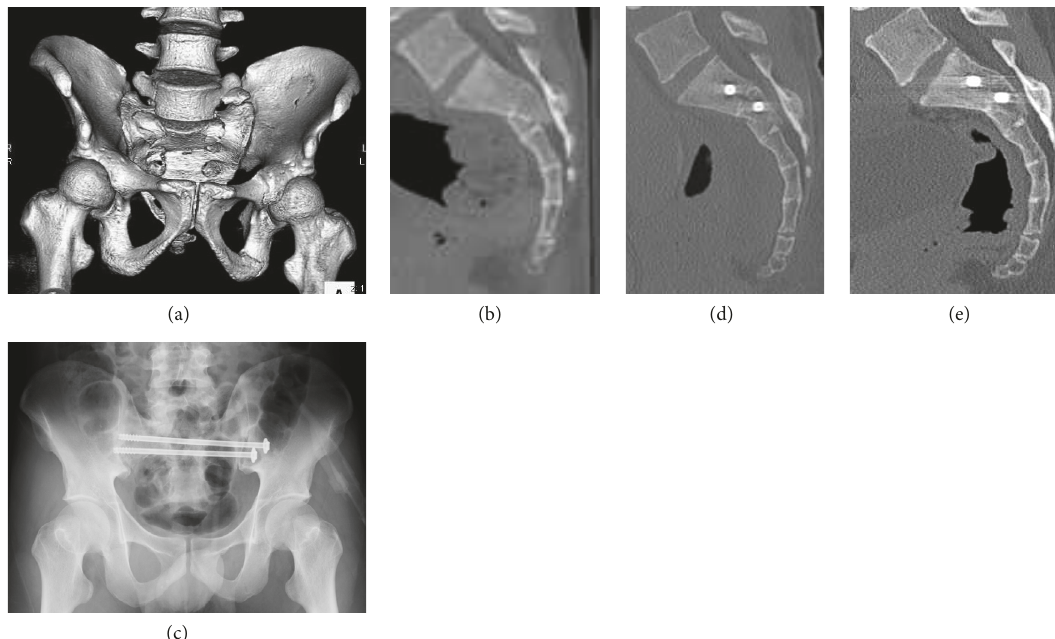
Figure 3: Case 1. A 25-year-old man who was injured from a fall from a height underwent S1 and S2 TSTI partial threaded screw fixation for a Roy-Camille type 2 U-shaped transverse sacral fracture. (a) Preoperative 3-dimensional CT reconstruction of the pelvis is shown. (b) Preoperative CT scan of the sacrum in the sagittal plane is shown (preoperative sacral kyphotic angle: 33 ∘ ; fracture translation: 10 mm). (c) Postoperative anteroposterior radiograph of the pelvis is shown. (d) Postoperative CT scan of the sacrum in the sagittal plane is shown (postoperative sacral kyphotic angle: 17 ∘ ; fracture translation: 2 mm). (e) Final follow-up CT scan of the sacrum in the sagittal plane is shown. Slight reduction loss was observed.